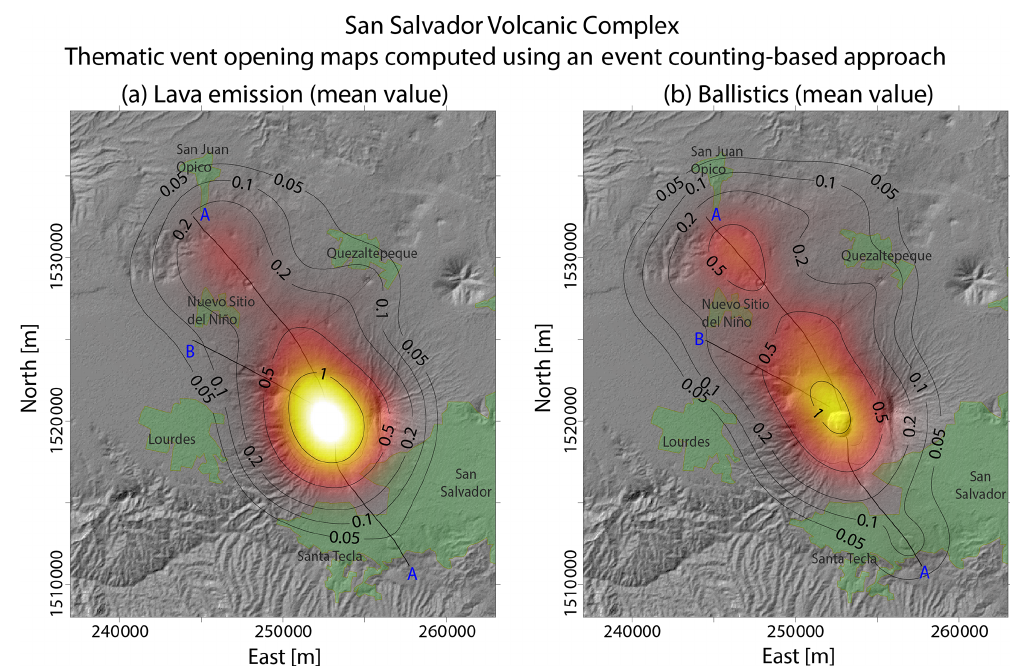
Figure 11. Density distributions of the probability of vent opening at the San Salvador volcanic complex (mean value) computed using an event-counting approach (i.e., the polygenetic central vent presents a weight higher than monogenetic vents). These maps, which are thematic, are associated with the occurrence of volcanic activity able to produce lavas flows (a) and ballistic fragments (b) . Results are expressed in percentage per km 2